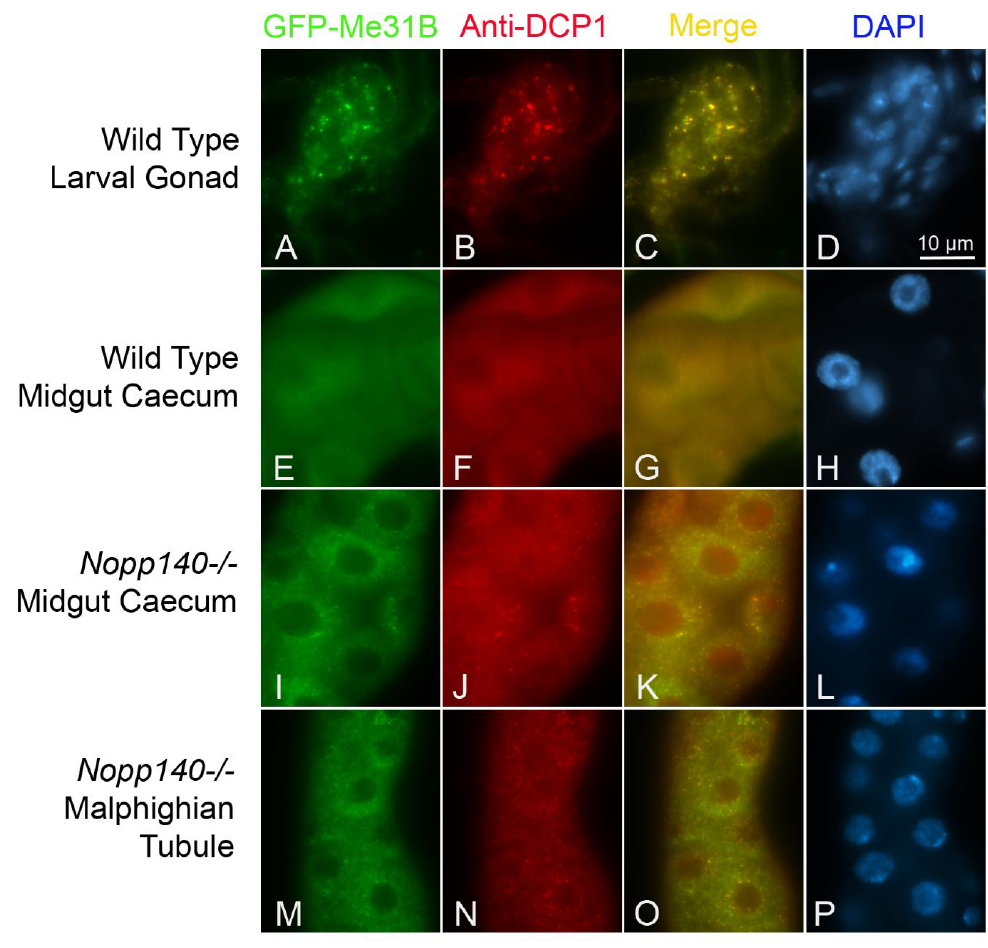
Figure 5. Nucleolar stress-induced midgut granules contain Processing (P) body markers: Maternal expression at 31B (Me31B) and Decapping Protein 1 (DCP1). GFP-Me31B was a GFP protein trap fusion expressed from the endogenous Me31B gene promoter. DCP1 was detected by immuno-fluorescence. ( A – D ) As a positive control, GFP-Me31B and DCP1 colocalized in P bodies present in wild type larval gonads. ( E – H ) As a negative control wild type midgut caecum contained the two P body markers, but they were diffusely distributed throughout the cells with no apparent formation of P bodies under non-stress conditions. (( I – L, M – P ), respectively) The KO121 Nopp140-/- midgut caecum and Malpighian tubules displayed colocalization of GFP-Me31B and DCP1 in the cytoplasmic granules supporting their identity as putative P bodies. Bar = 10 µm for all images.